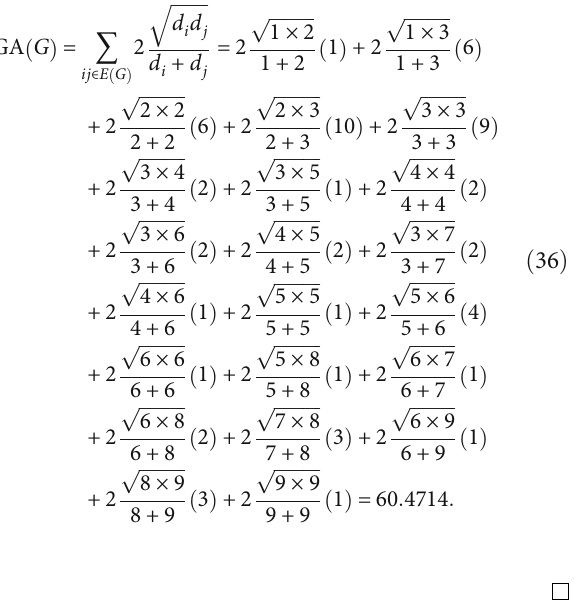
ffiffiffiffiffiffiffiffiffiffi p 2 × 3